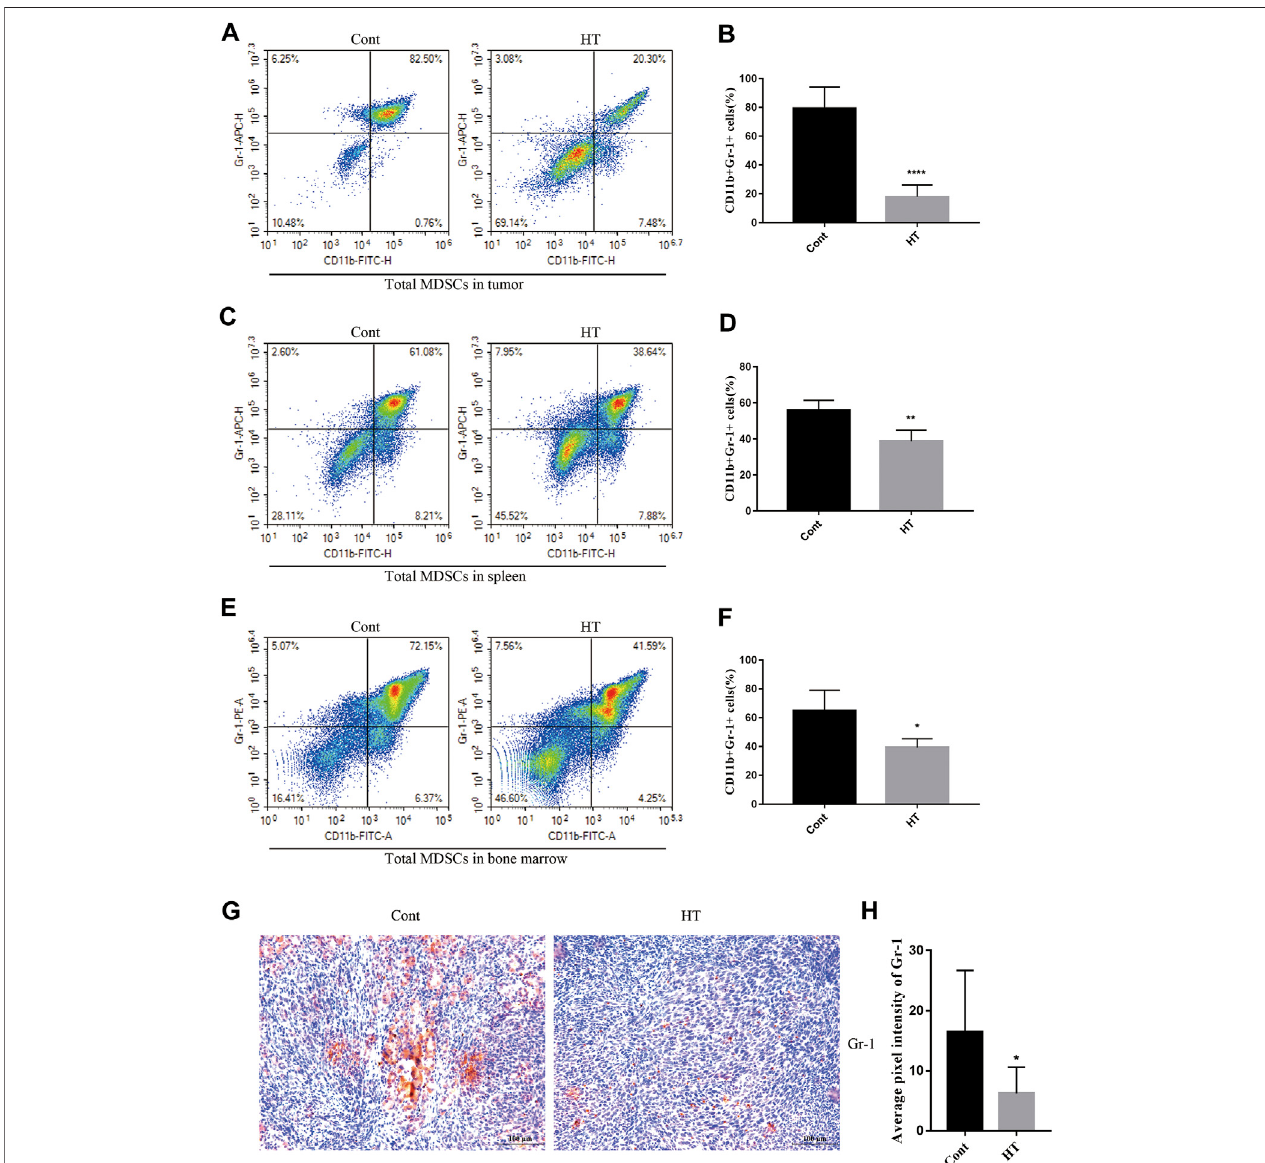
FIGURE3| HTinhibitsaccumulationofMDSCsinthemice withorthotopic pancreatic tumor. Thetumors,spleens andBMofmice inthecontrolgroupand theHT treatmentgroupwereisolated.TheproportionofCD11b+Gr-1+cellsinthetumors( n (cid:2) 5ineachgroup) (A,B) ,spleens( n (cid:2) 5ineachgroup) (C,D) andBM(n (cid:2) 3ineach group) (E,F) wasdetectedusing fl owcytometry.Gr-1expressioninmousepancreatictumorswasdetectedusingIHC.Representativeimagesandquanti fi cationofGr-1 from the control group and the HT treatment group (G,H) . Eight images from four mice in each group were analyzed for average pixel intensity and statistics (* p < 0.05, ** p < 0.01, **** p <